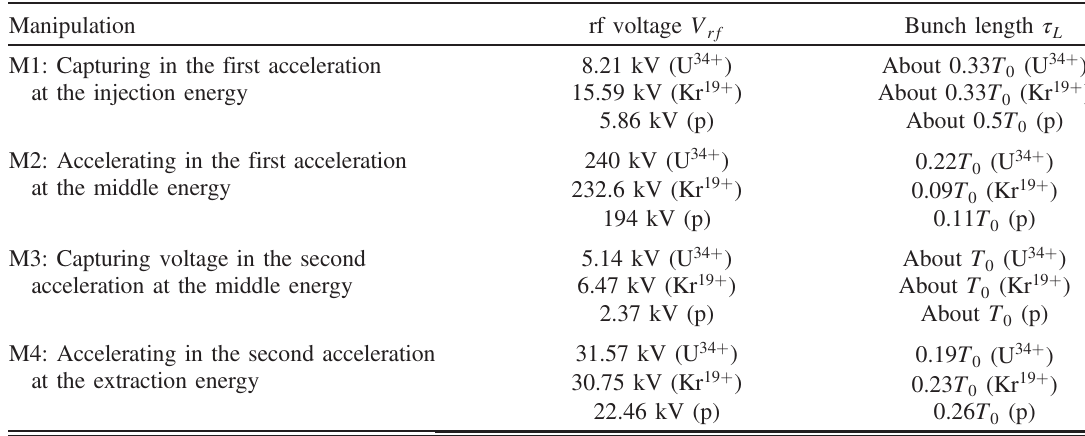
TABLE IV. The amplitude of the rf voltage and the related bunch length in the different manipulations with three reference